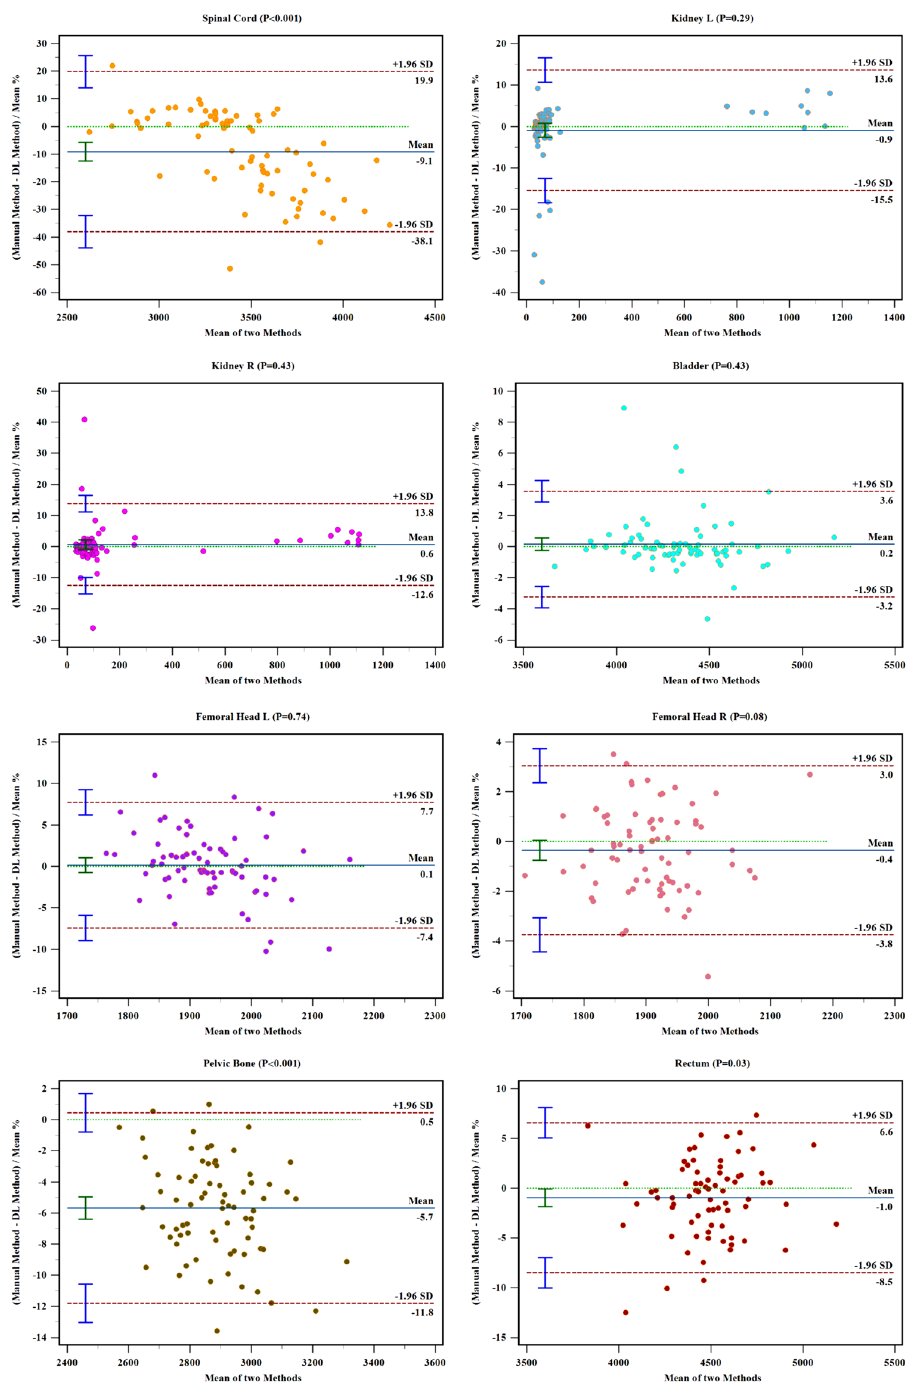
Figure 4. Bland–Altman plot for OARs. The brown horizontal dotted lines represents the upper and lower bounds of 95% limit agreement; the blue horizontal solid lines represent the average of the differences; the green horizontal dotted lines represent the location with difference equal to